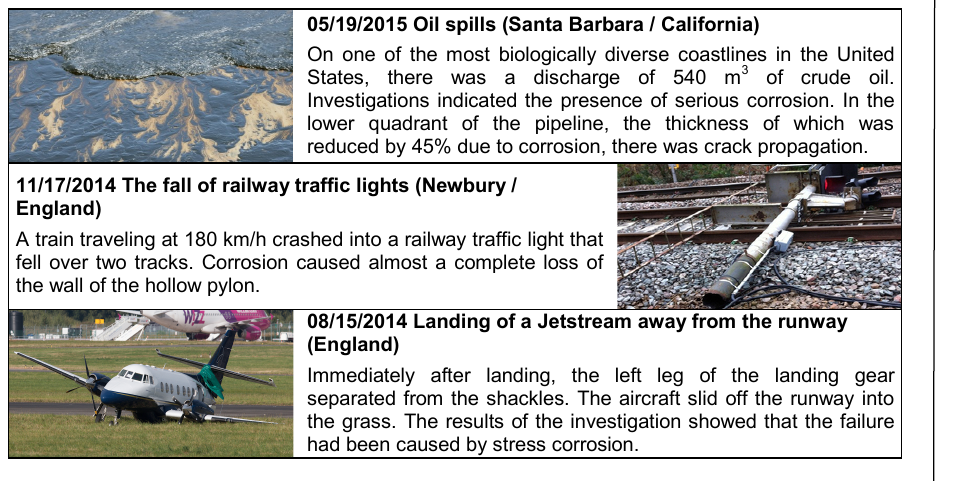
Table 2 – Overview of several characteristic accidents caused by corrosion Таблица 2 – Обзор нескольких характерных несчастных случаев , вызванных